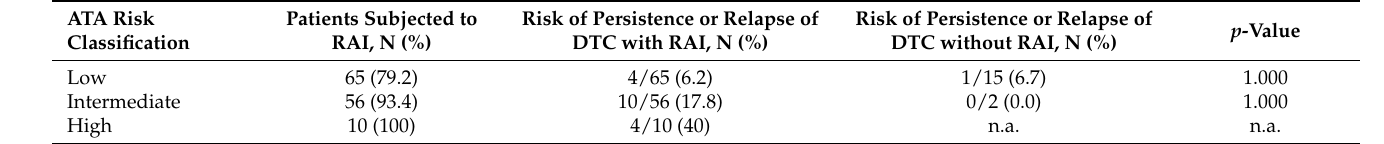
Table 4. Relative risk of persistence or relapse of disease at last follow-up as per post-operative RAI administration in DTC stratified by initial ATA risk